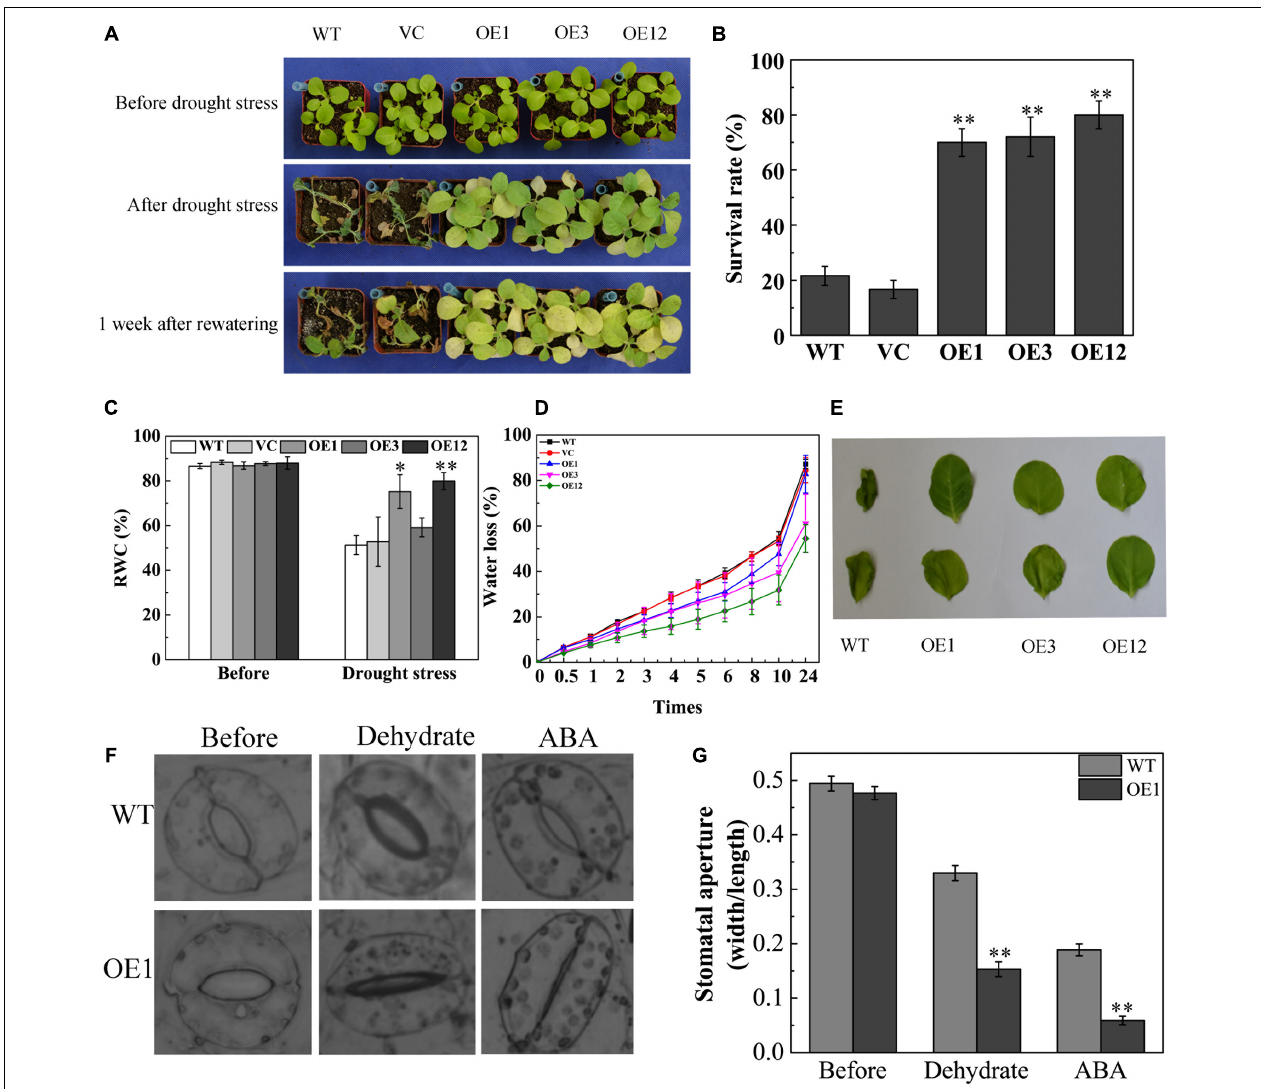
FIGURE 5 | Drought tolerance of TaODORANT1 overexpressed tobacco plants. (A) Phenotype of WT, VC, and OE lines (OE1, OE3, and OE12) after drought treatment. (B) Survival rate statistics after re-watering for 1 week. (C) RWC of leaves after drought stress. (D) Water loss rate of detached leaves. (E) Phenotype of detached leaves after 24 h dehydration. (F) Stomatal aperture after dehydration or ABA treatment. (G) Width/length ratio of stomata. Three independent biological replicates were performed and produced similar results. Vertical bars refer to ± SE ( n = 3). Asterisks indicate significant difference between the WT and the transgenic lines ( ∗ P < 0.05; ∗∗ P <